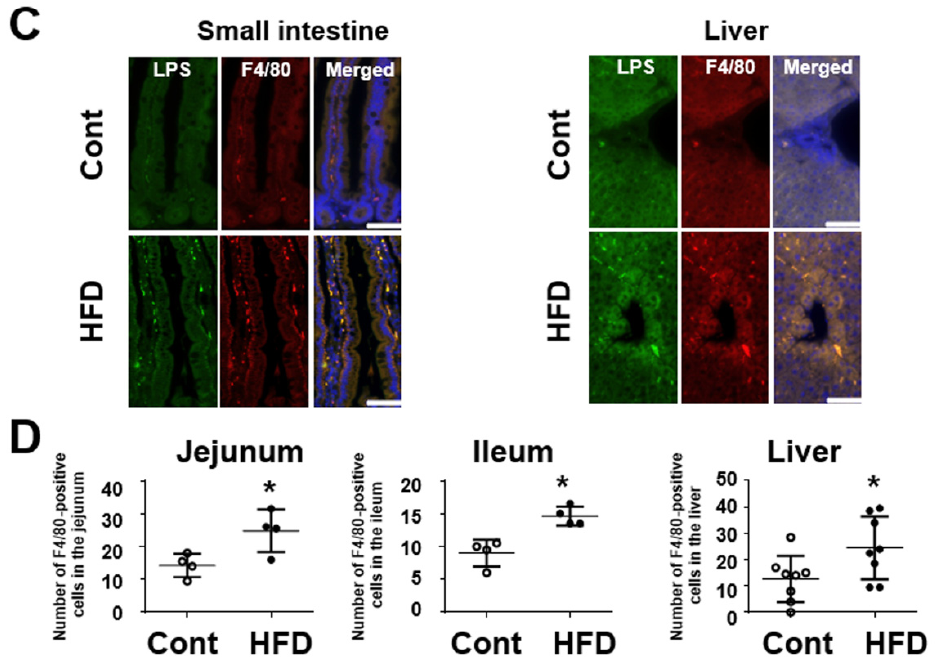
Figure 7. Effect of a HFD on immunoreactivity of LPS in the small intestine and liver in mice. ( A ) Images showing immunostaining of LPS in the small intestine. Graphs showing the number of LPS-positive cells in the small-intestinal mucosa (each group, n = 4). Bar = 100 µ m. ( B ) Images showing immunostaining of LPS in the liver. Graphs showing the number of LPS-positive cells in the liver (each group, n = 8). Bar = 100 μ m. ( C ) Immunohistochemical double staining for LPS (green) and F4/80 (red) in the small intestine and the liver. Bar = 50 μ m. ( D ) Number of F4/80-positive cells in the small intestine and the liver. Results are expressed as the mean ± SD. * p < 0.05 vs. control group. Cont, control; HFD, high-fat diet.